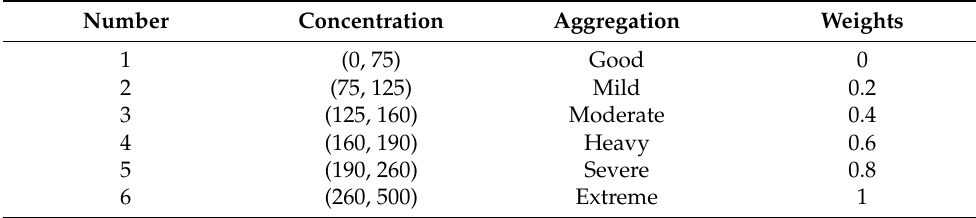
Table 1, the aggregation levels are defined as follows: Level 1 for non-VOCs pollution, Level 2 for light VOCs pollution, Level 3 for moderate VOCs pollution, Level 4 for moderate to heavy VOCs pollution, Level 5 for heavy VOCs pollution and Level 6 for severe VOCs pollution. The corresponding rank weights are defined as the degree of aggregation: 0 for no aggregation, 0.2 for low aggregation, 0.4 for medium aggregation, 0.6 for medium to high aggregation, 0.8 for high aggregation and 1 for very high aggregation. Table 1. VOCs aggregation